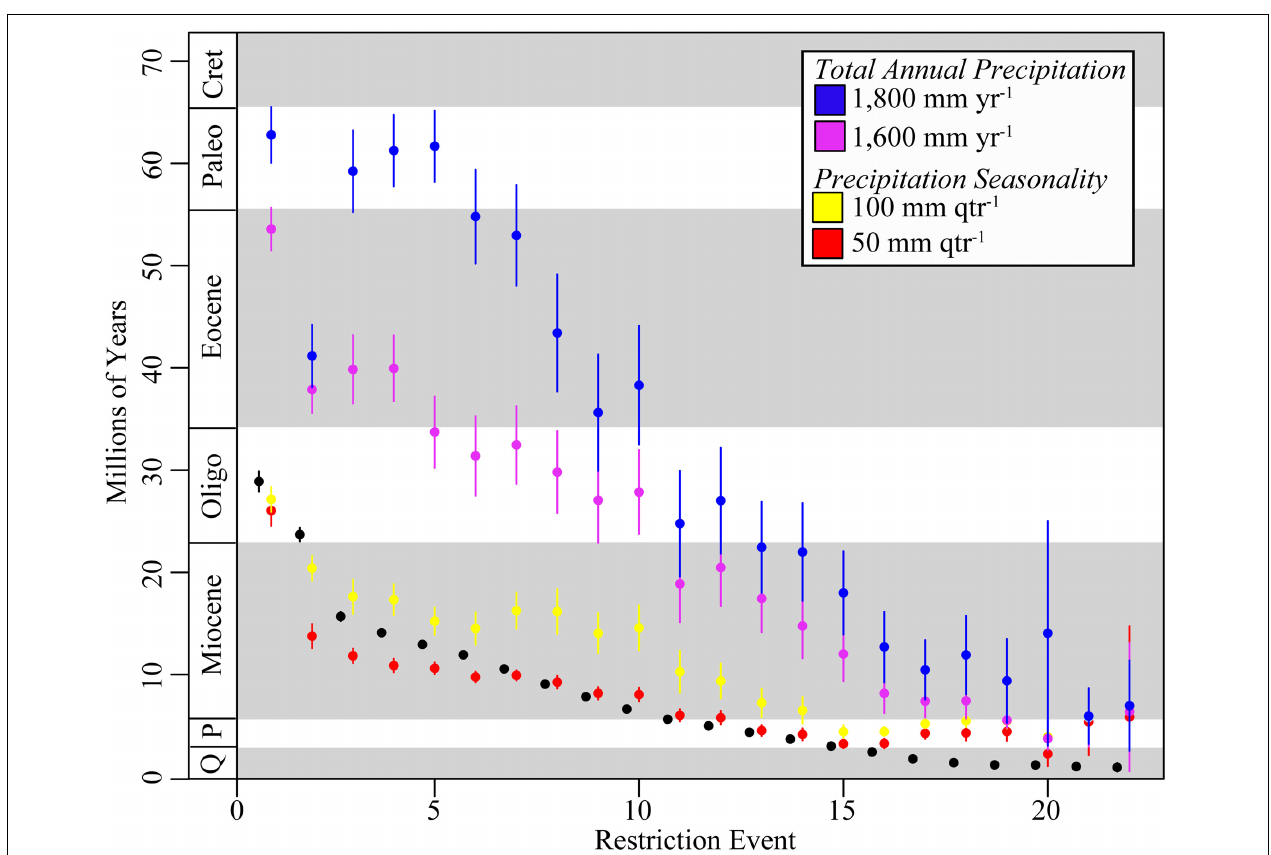
FIGURE 4 | Age of geographic restriction to Mexico, and adaptations to seasonal dry tropical forest climate in Mexico. Mean age of geographic restrictions to Mexico shown with black circles. Mean age of the evolution of total annual precipitation ( ≤ 1800mm yr − 1 ; blue circles) and seasonal precipitation ( ≤ 50mm qtr − 1 ; red circles) in Mexican endemics as defined for modern seasonally dry tropical forest shown with blue and red circles, respectively. Also included is (i) the mean age of the evolution of total annual